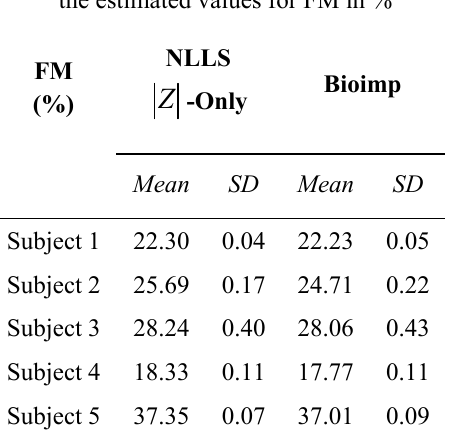
Table VII. Mean and Standard Deviation of the estimated values for FM in %